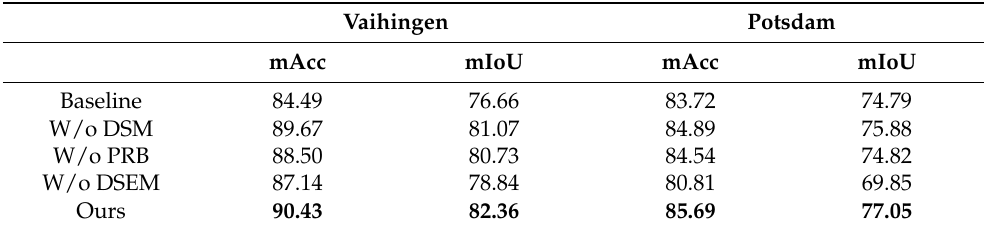
Table 4. Ablation study on the Vaihingen and Potsdam datasets.